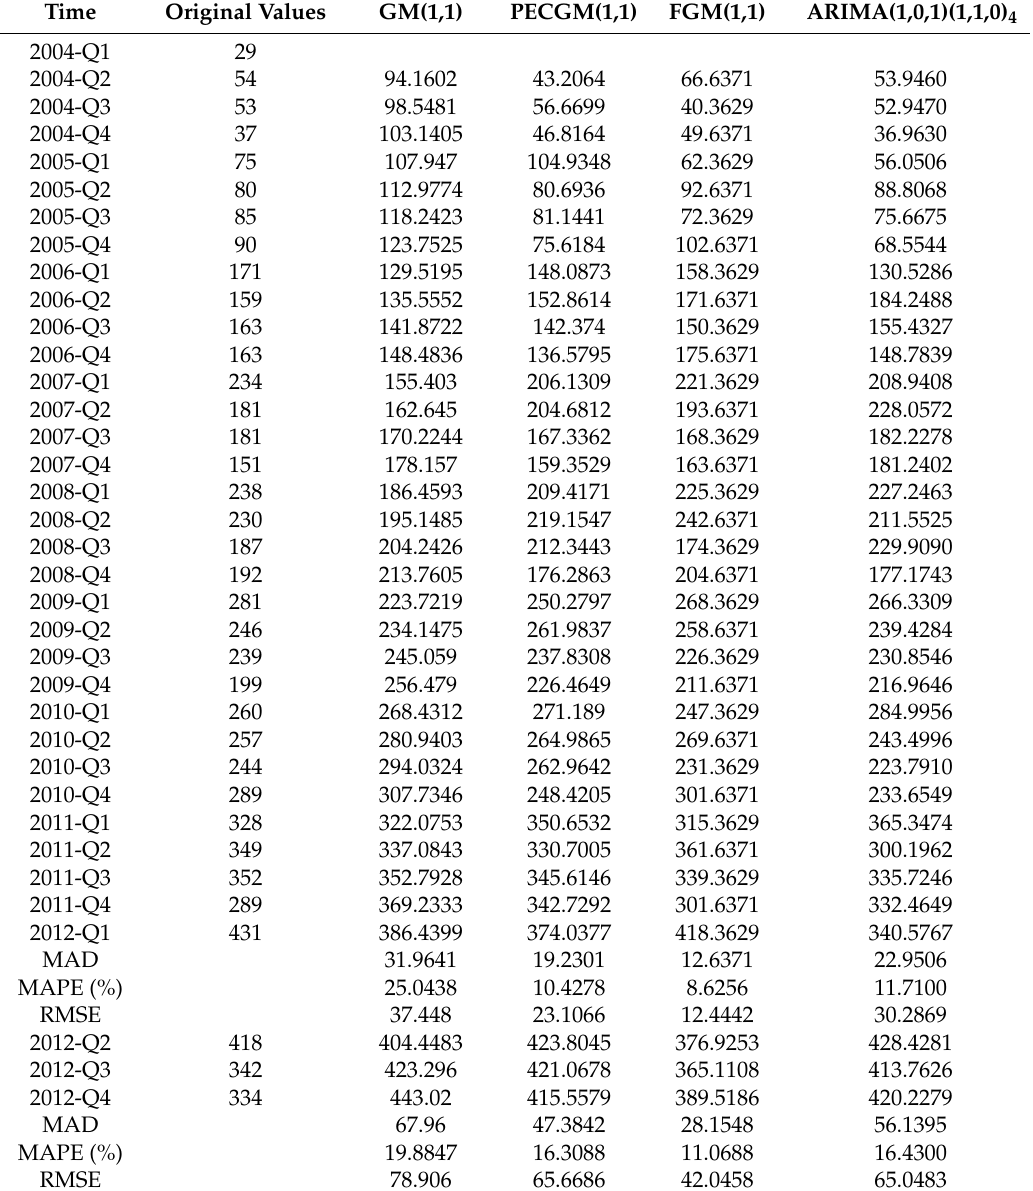
Table 1. Forecasting results and performance evaluation of original values, GM(1,1) model,